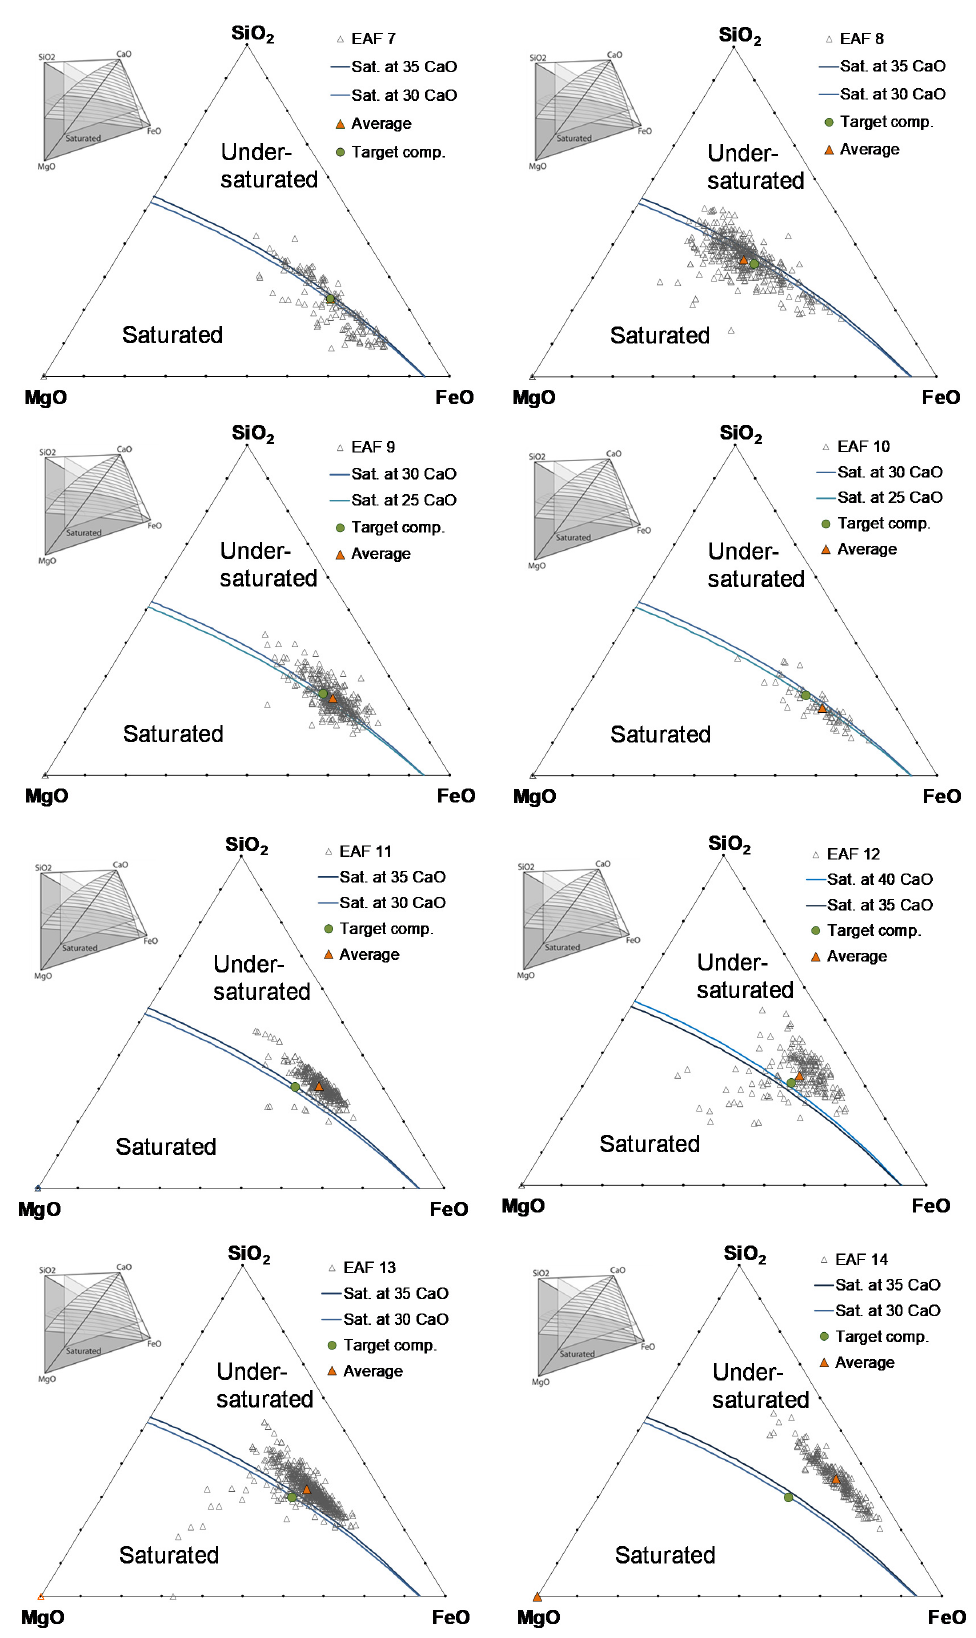
Figure 6. Distribution of slag analysis data from EAF heats for carbon steelmaking, in the system CaO–SiO 2 –FeO–MgO; lines indicate MgO saturation at 30% to 40% CaO and 1600 °C.